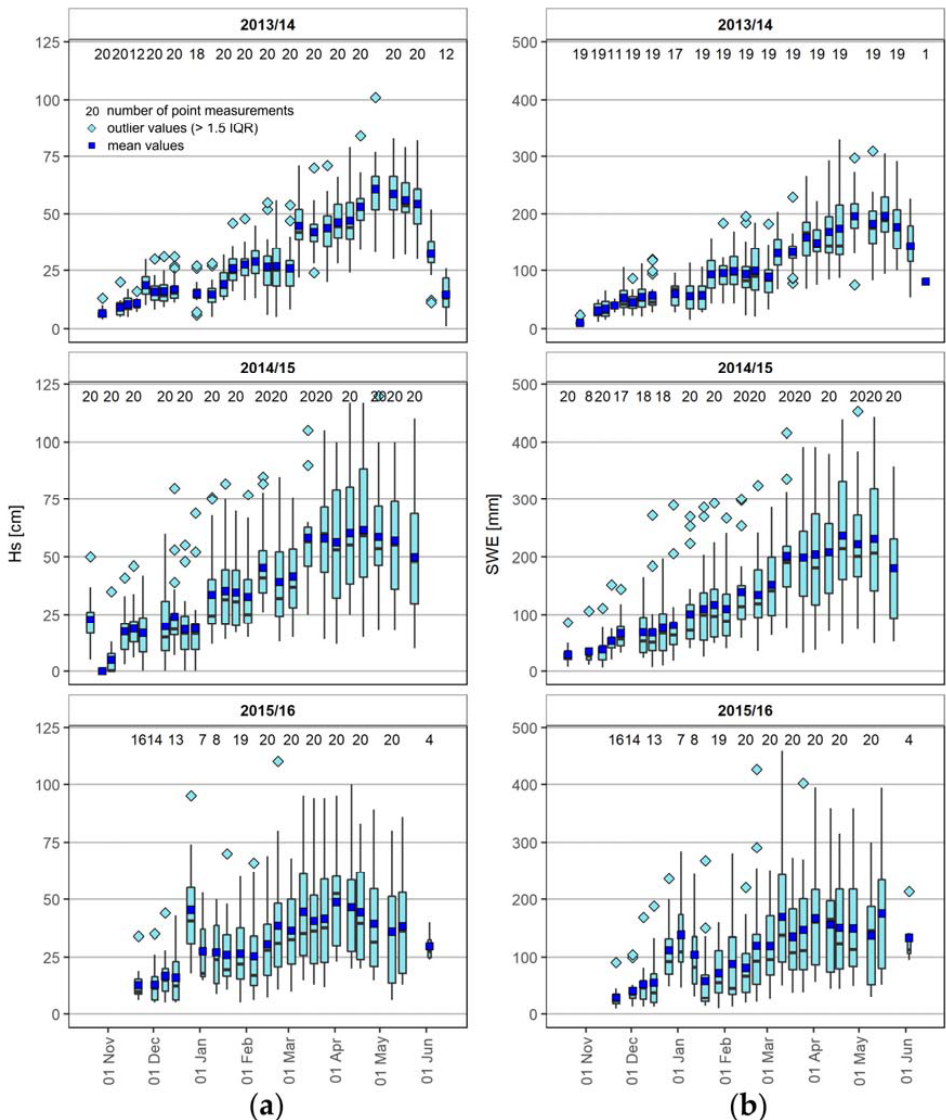
Figure 5. Results of weekly ( a ) snow depth and ( b ) snow water equivalent manual measurements in the Fuglebekken catchment in 2013/14, 2014/15 and 2015/16 in boxplot format [68]. The results indicate that the snow cover in Fuglebekken catchment usually starts to disappear rapidly in late May/early June, when positive air temperatures begin to dominate [43]. The earliest occurrence of bare ground was recorded in 2016, caused by the early onset of above-zero air temperatures in May and generally low snow depths/SWE (Table 1; Figure 5). The longest duration of the snow cover occurred in spring 2015, which was associated with the prevalence of freezing temperatures until the end of May [69] (Table 1). The classified images allow the quantification of SCE losses and determine the exact point in time when SCE drops below 50%, which is considered to be the last day of snow cover in synoptic station records [70,71]. At manned stations, SCE is only visually evaluated by observers, which may lead to data inconsistencies. Automatic stations do not provide such information at all, which is important for climate change monitoring. Results from the time-lapse camera clearly indicate that SCE dropped below 50% on 14 June in 2014, 15 June in 2015